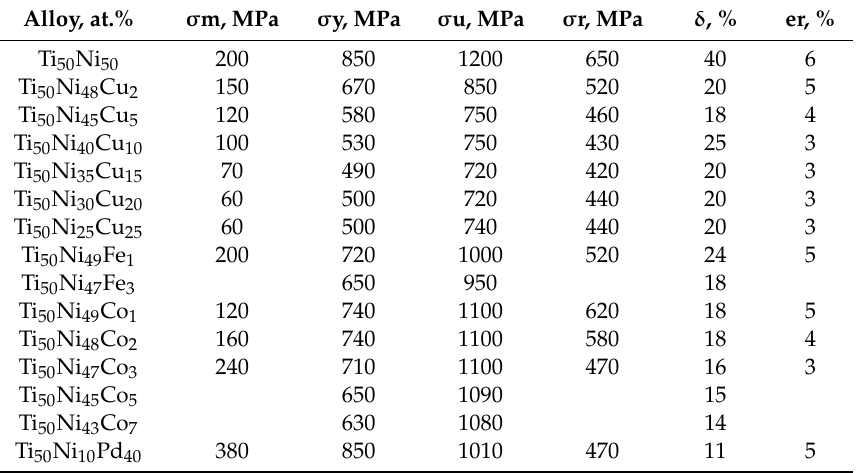
Table 8. Mechanical properties of fine-grained (FG) alloys at room temperature. Alloy, at.%